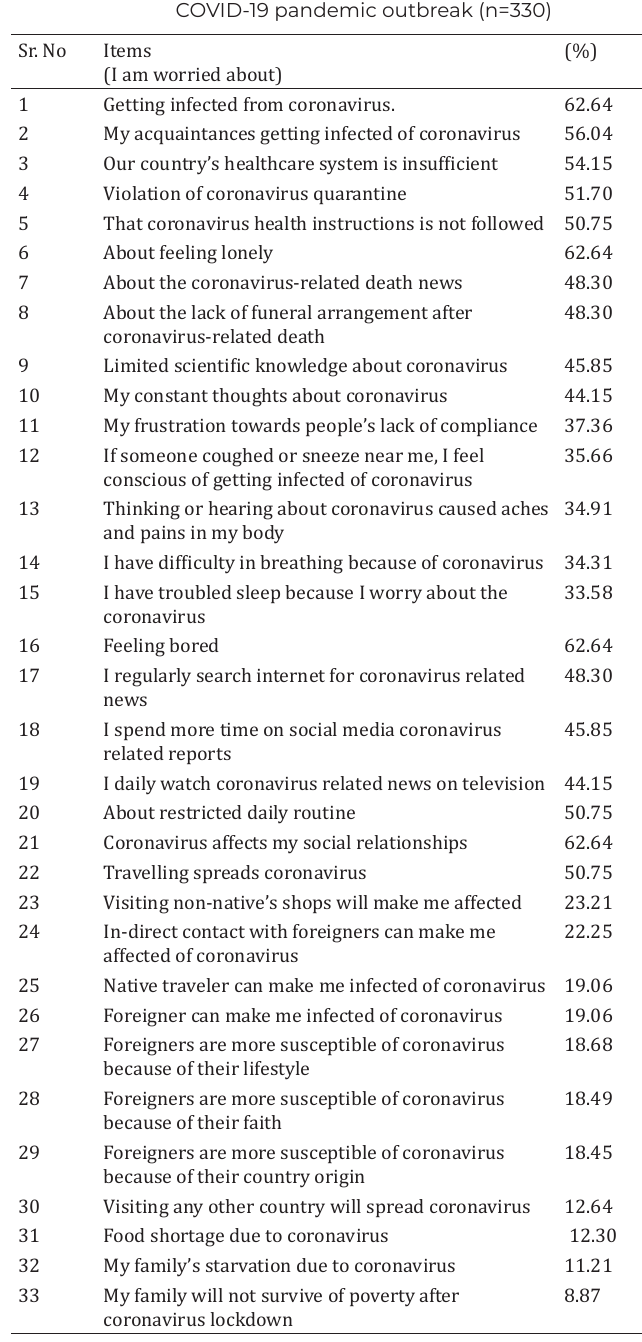
Medical and emergency and Critical Care Nursing students’ anxiety (Impact of COVID-19 Scale ICVS) (Mukhtar et al., 2020) related to COVID-19 pandemic outbreak (n=330)